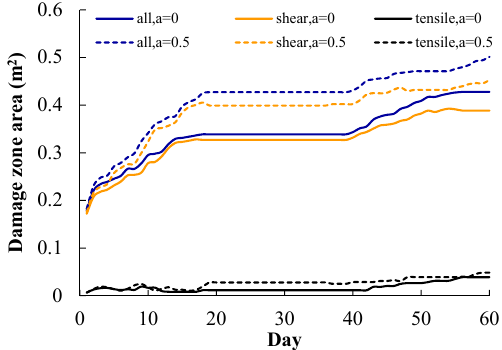
Figure 17. Variation of shear and tensile damage zone area during heating stage.